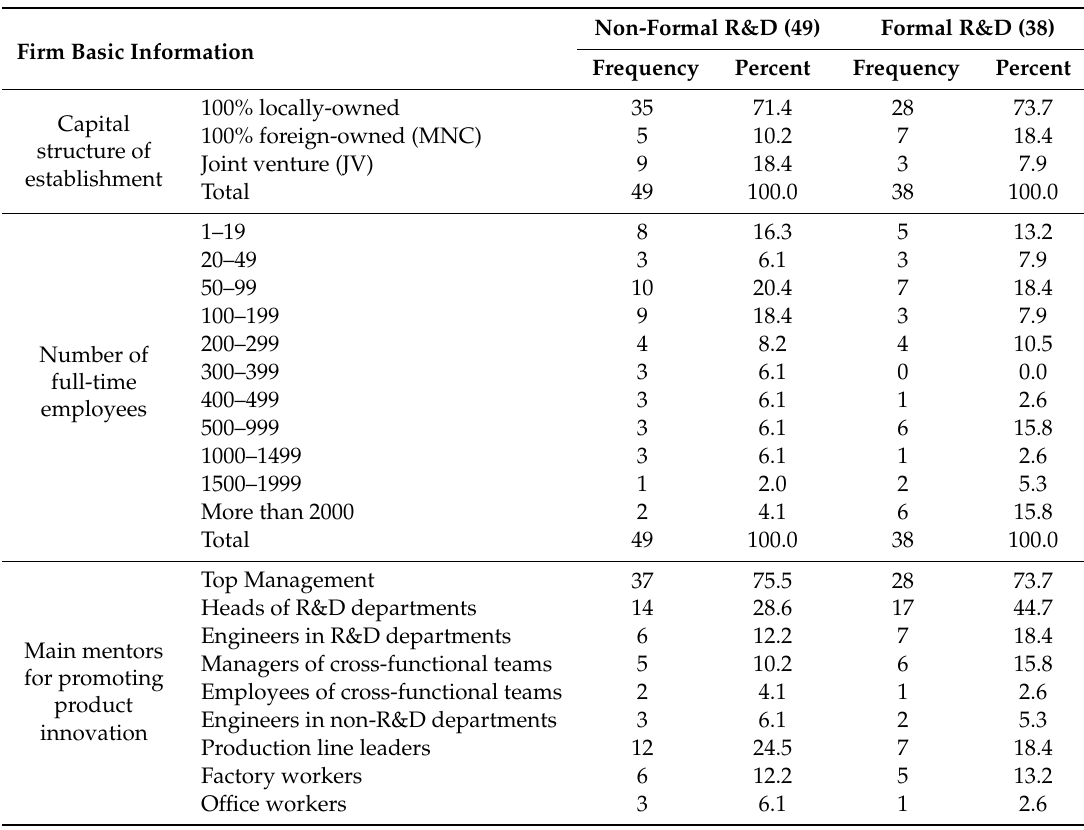
Table 6. Firms’ basic